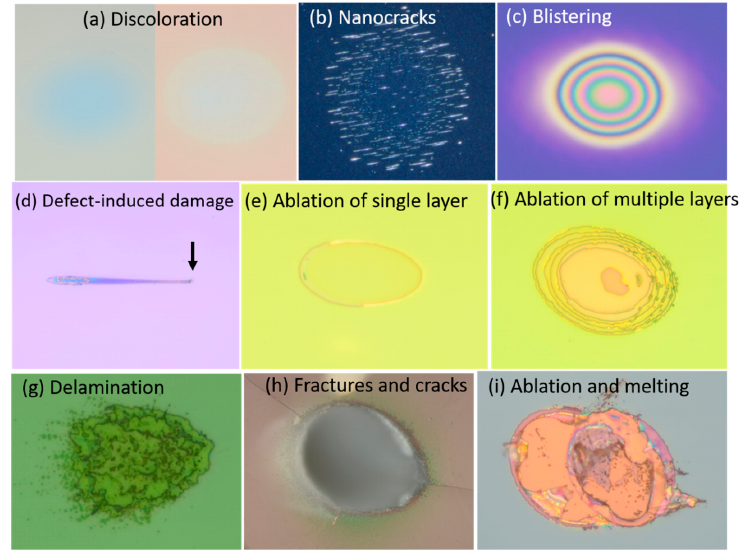
Figure 1. Various types of femtosecond laser damage morphologies ( a – i ) on the surface of Multi-layer dielectric (MLD) optical coatings.